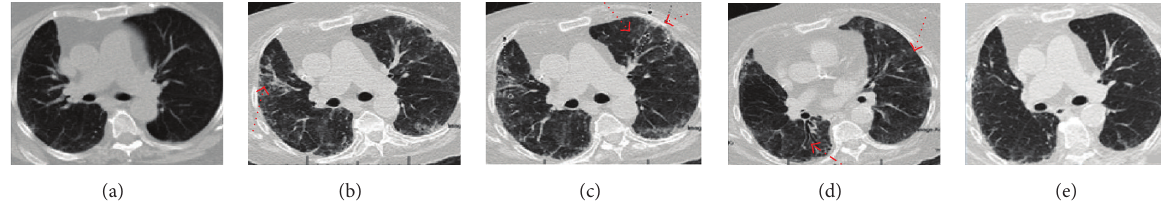
Figure 2: Chest CT at MDS diagnosis (a). Chest CT obtained after 11 cycles of decitabine demonstrating bilateral reticulonodular infiltrates ((b), arrow), subtle early honeycombing (black arrow) in posterior right lung base ((b) and (c), arrow), increased bronchial wall thickening ((d), arrow), and interstitial markings (d). Chest CT after 8 weeks of oral steroids showing progressive resolution of infiltrates